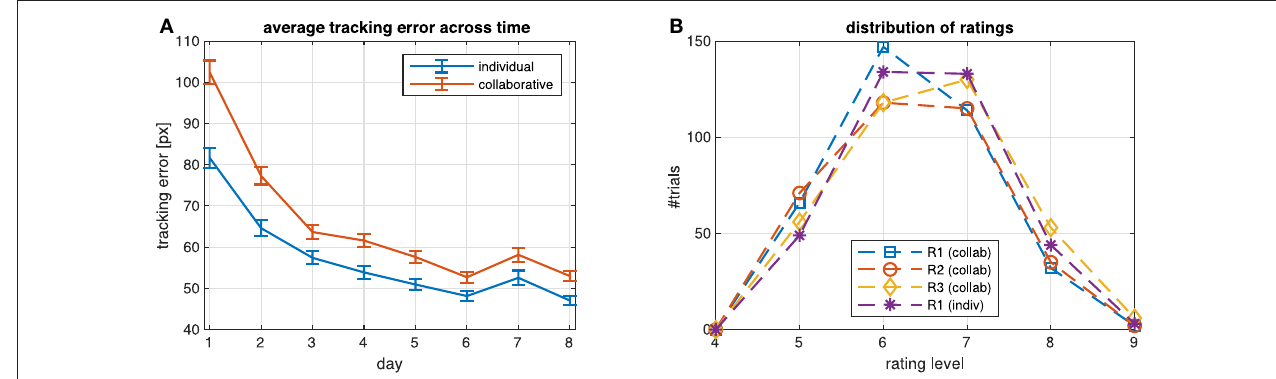
FIGURE 2 | (A) Average tracking error across all subjects for each day of participating in the study. ECG was recorded on days 7 and 8, RR and EDA on every day. (B) Distribution of ratings R1-3 from all subjects in the two conditions (collaborative/individual) on days 7 and 8 after correcting outliers and eliminating rating levels with an insufficient number of